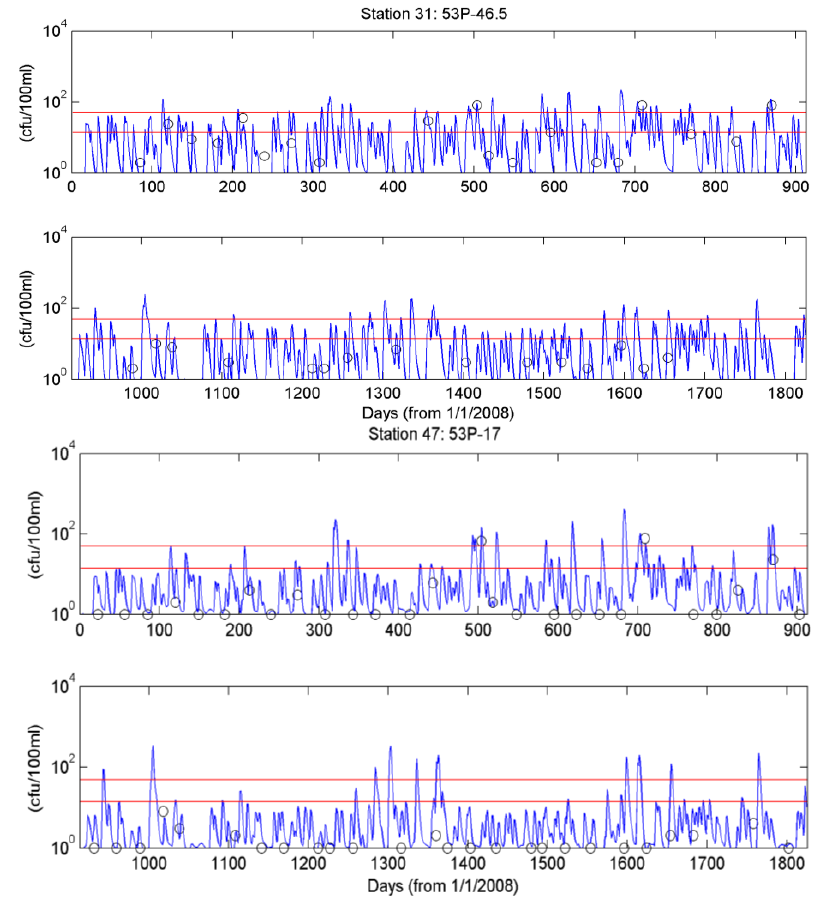
Figure 11. Comparison of model simulation of bacterial concentrations and observations in the tidal marsh area and the middle of the Poquoson River. J. Mar. Sci. Eng. 2016 , 4 , 69